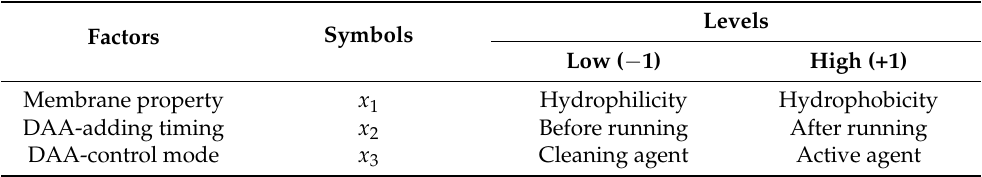
Table 3. Factors and levels of operating parameters in